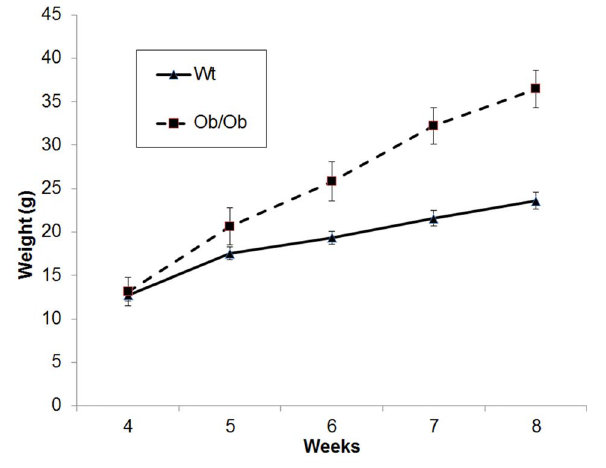
Figure 4. Weights of WT and Lep ob animals from our breeding colonies genotyped by HRM method.